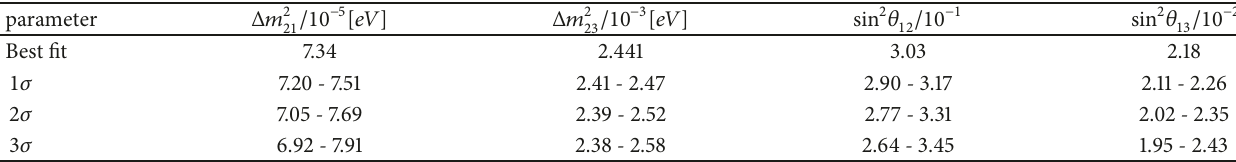
Table 2: Recent global data table for best-fitvalues of the oscillation parametersand their range at1 𝜎 , 2 𝜎 , and 3 𝜎 in the case of three neutrinos with Inverted Ordering spectrum